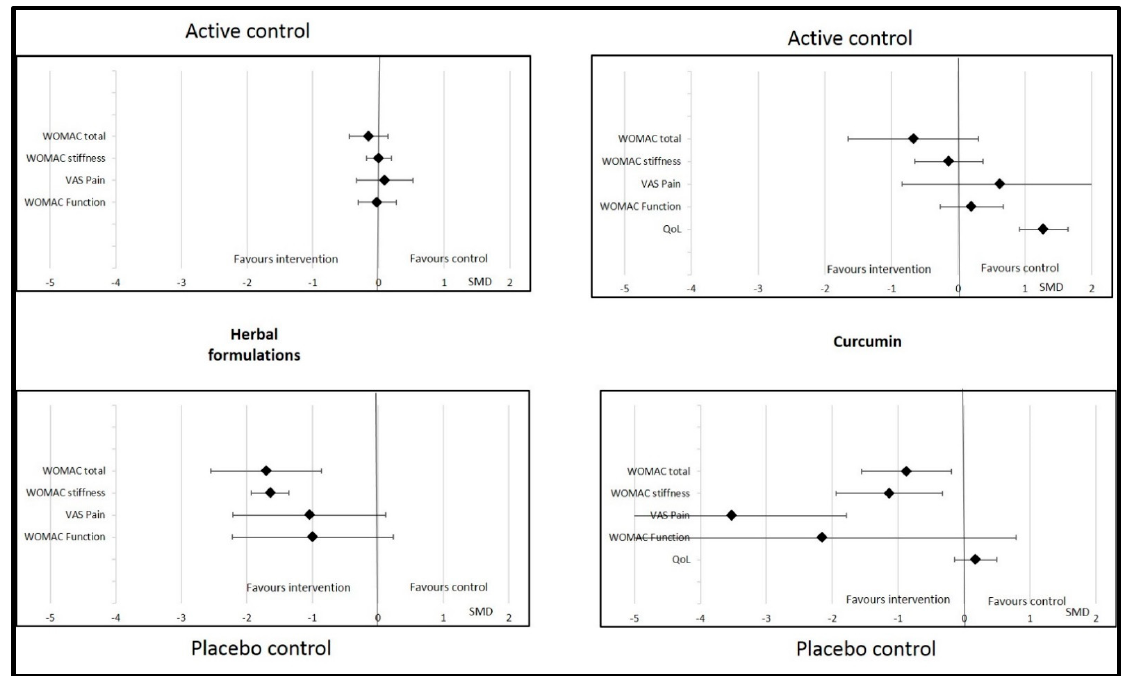
Figure 4. Effects of curcumin and herbal formulations on osteoarthritis parameters depending on type of control. Data are presented at standardized mean differences (SMDs) and confidence intervals. VAS = visual analogic scale; WOMAC = Western Ontario and McMaster Universities Osteoarthritis Index; QoL = quality of life.